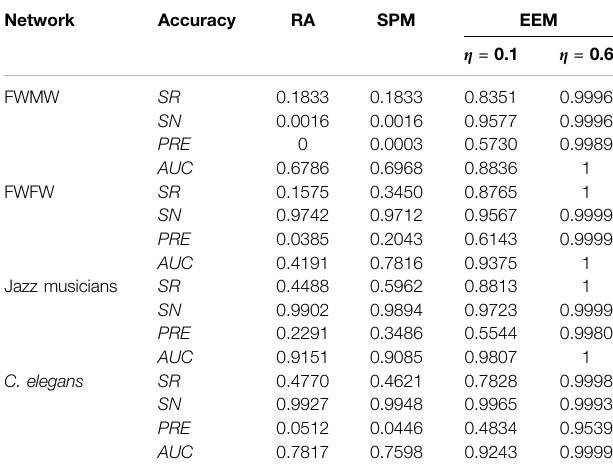
TABLE 3 | The value of four indices of reconstruction accuracy for four empirical networks.